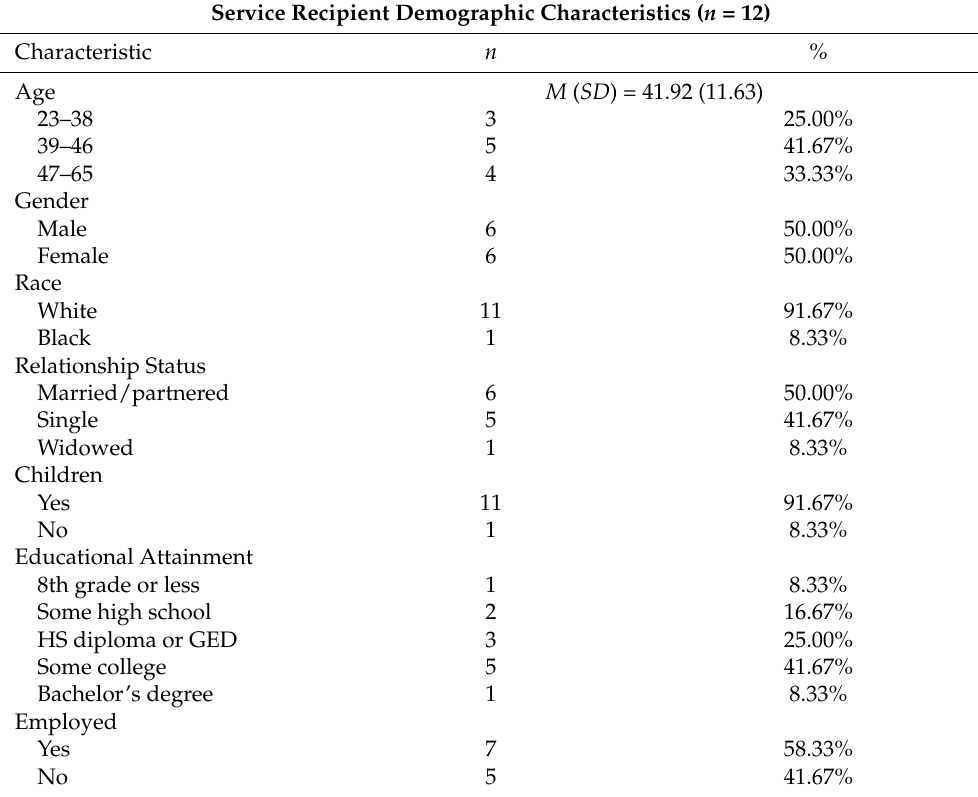
Table 1. This table provides demographic data for the service recipient participants of the sample. Demographic data are not available for the program coordinators, and vendors were not